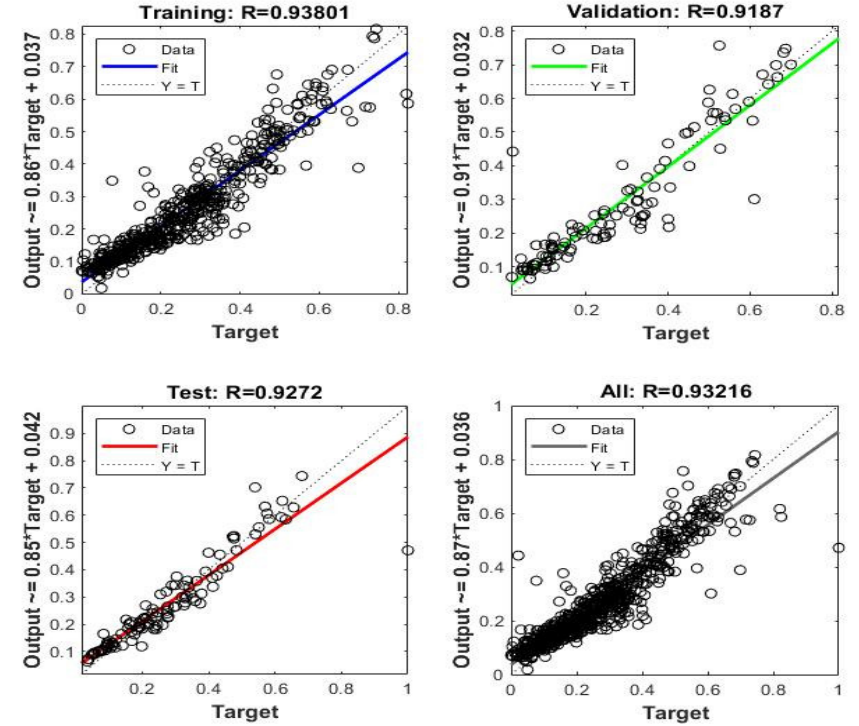
Figure 3. Results of regression analysis for the best ANN model.